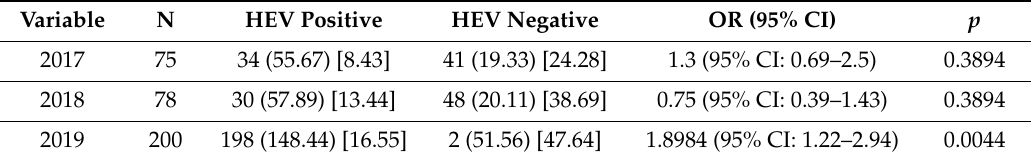
Table 2. Time factor of the HEV seroprevalence. a N denotes the number of animals; OR is the odds ratio; 95% CI confidence interval; p — p -value and in the brackets [the chi-square statistic for each cell].